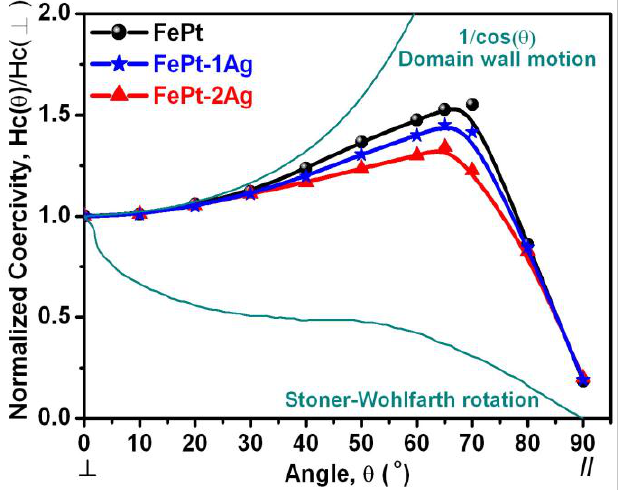
Figure 4. Angular dependence of coercivity for the [Fe/Pt] 18 multilayer films without and with insertion of a single and two ultrathin Ag (0.5 nm each) nanolayers. The angle is referred to that between the easy axis (film normal) and the applied field direction.